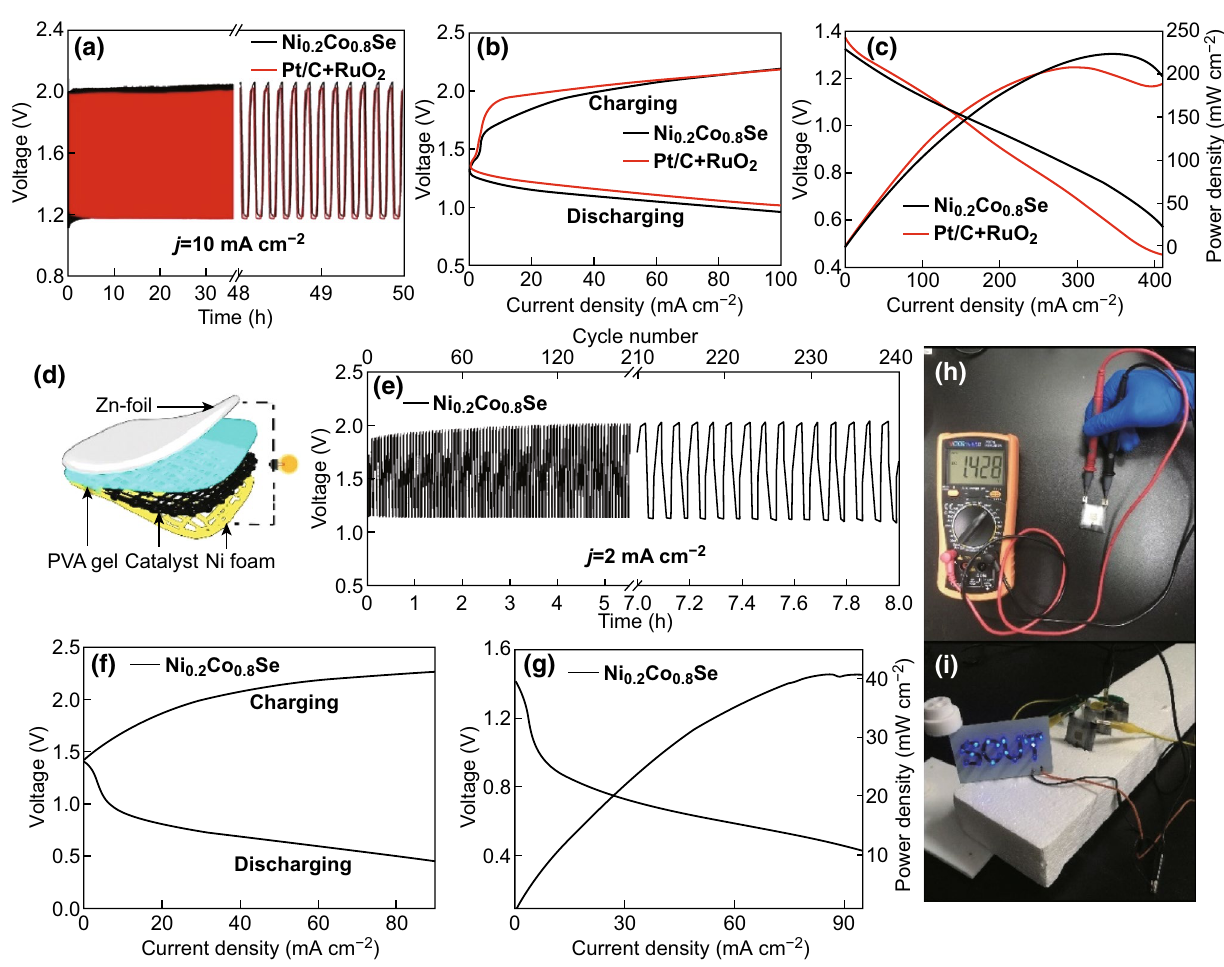
Fig. 6 a Cycling performance of the rechargeable ZAB using Ni 0.2 Co 0.8 Se at 10 mA cm −2 , where each cycle lasted 5 min. b Charge–discharge polarization curves of the rechargeable ZABs using Ni 0.2 Co 0.8 Se and Pt/C + RuO 2 . c Polarization and power density curves of the ZABs using the Ni 0.2 Co 0.8 Se and Pt/C + RuO 2 catalysts. d Schematic of the self‑made all‑solid‑state ZAB. e Cycling performance of the all‑solid‑state ZAB using Ni 0.2 Co 0.8 Se at 2 mA cm −2 , where each cycle lasted 2 min. f Charge–discharge polarization curves of the all‑solid‑state ZAB using